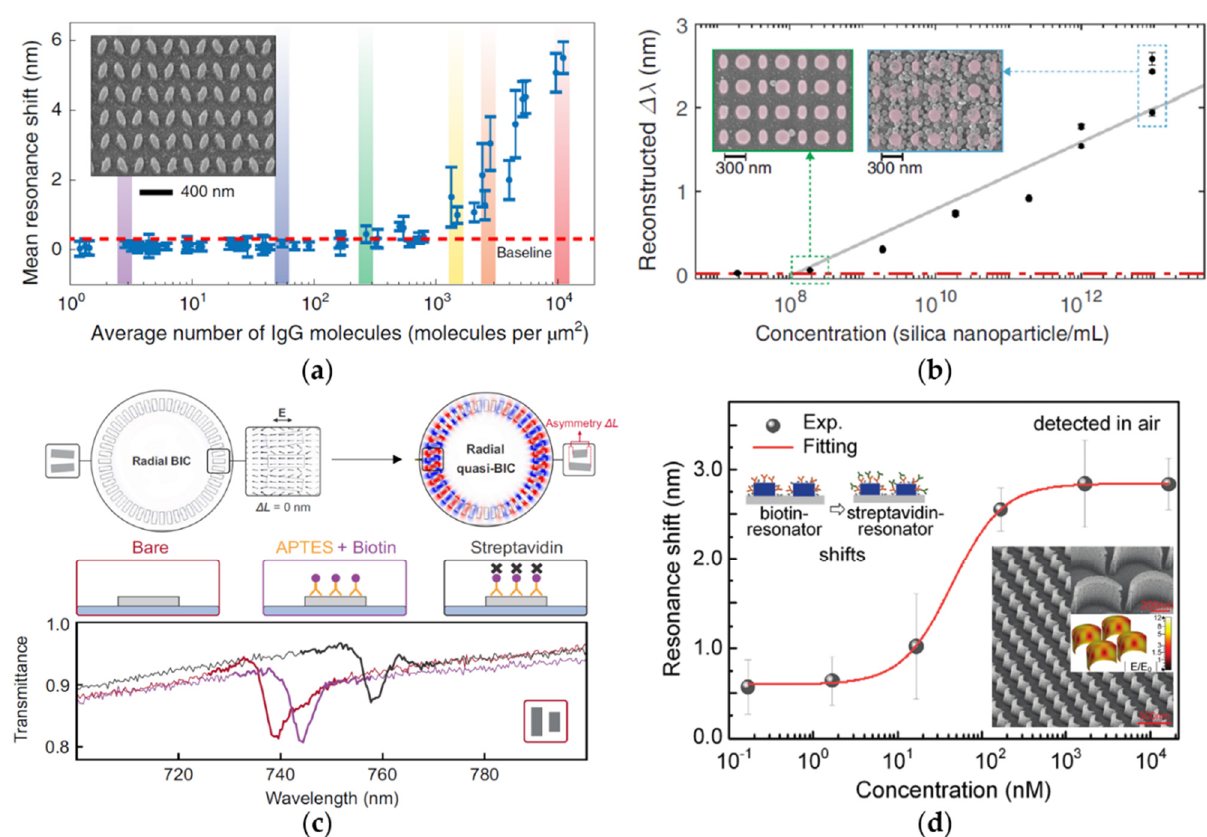
Figure 4. BIC biosensors composed of all-dielectric metasurfaces. ( a ) A symmetry-broken elliptical silicon metasurface for hyperspectral imaging biodetection of IgG (reprinted with permission from [64], ©2019, Springer Nature); ( b ) the reconstructed spectral shift calibration curve of diatomic metasurfaces for detection of biotinylated silica nanoparticles (reprinted with permission from [65], ©2021, Yasaman Jahani et al., CC BY license); ( c ) polarization-independent symmetry-broken ring metasurface for biotin-streptavidin specific binding experiment (reprinted with permission from [66], ©2022, Lucca Kühner et al., CC BY license); ( d ) all-dielectric crescent metasurface for biotin-streptavidin specific binding experiment (reprinted with permission from [67], ©2021, Juan Wang et al., CC BY license);